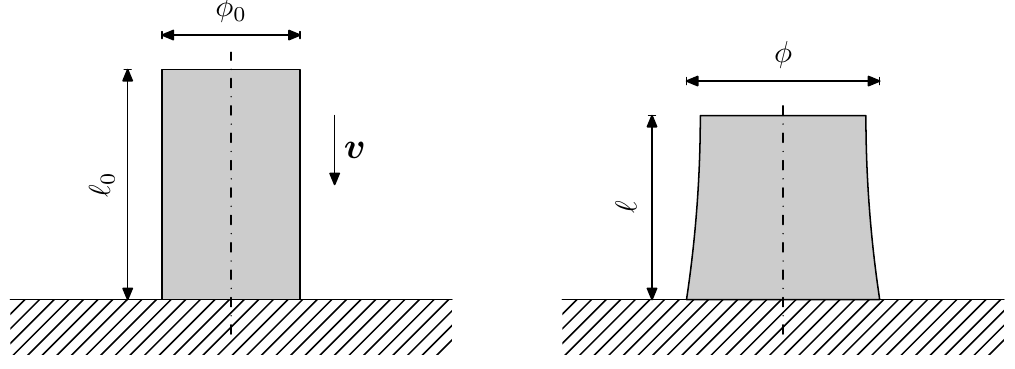
Figure 2. Schematic of Taylor’s impact test.